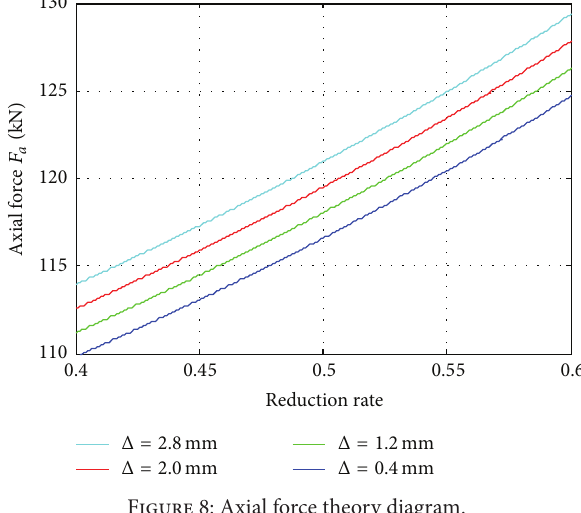
Figure 8: Axial force theory diagram. Table 2: Roller vibration measurement (unit: m ⋅ s −2 ). Average Peak value